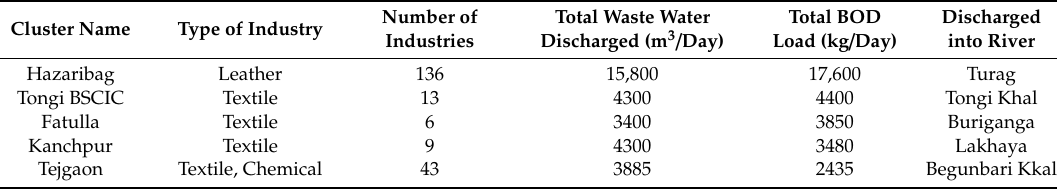
Table 1. Industries in and around